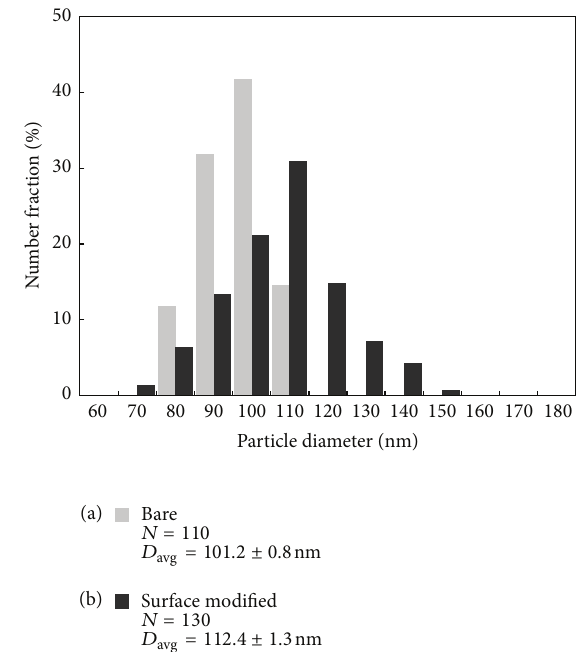
Figure 1: Size distribution of (a) bare and (b) surface modified silica nanoparticles.SurfacemodifiedsilicasamplesincludebothFandFF